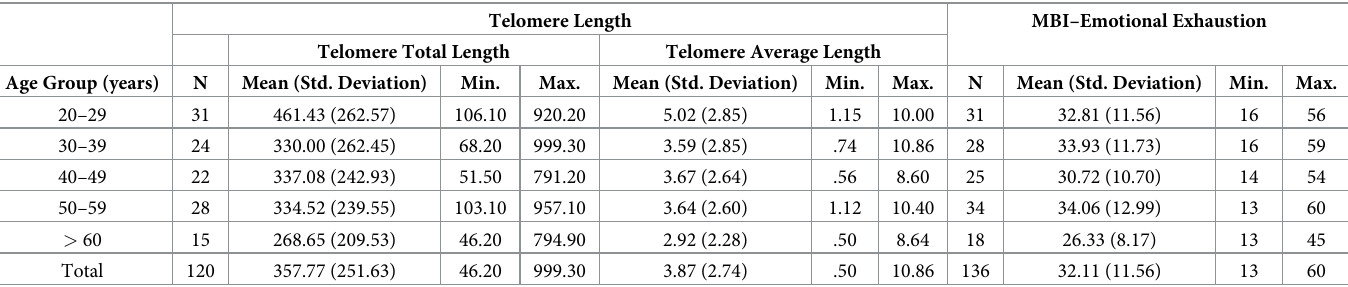
Table 8. Nurses’ age groups, telomere lengths, and emotional